Question: According to the figure, is the described quantity increasing or decreasing?
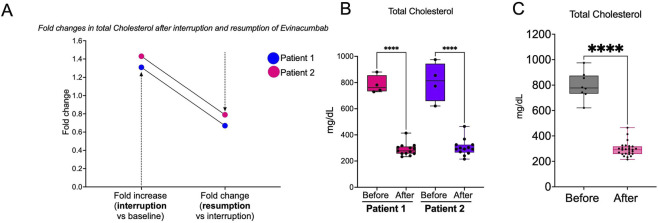
Answer: increasing